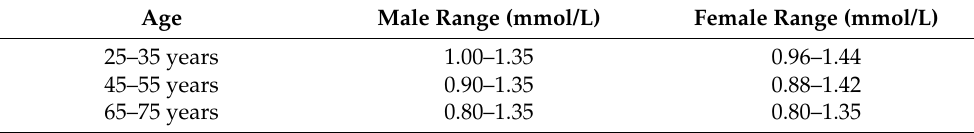
Table 1. Reference values for TmP/GFR in